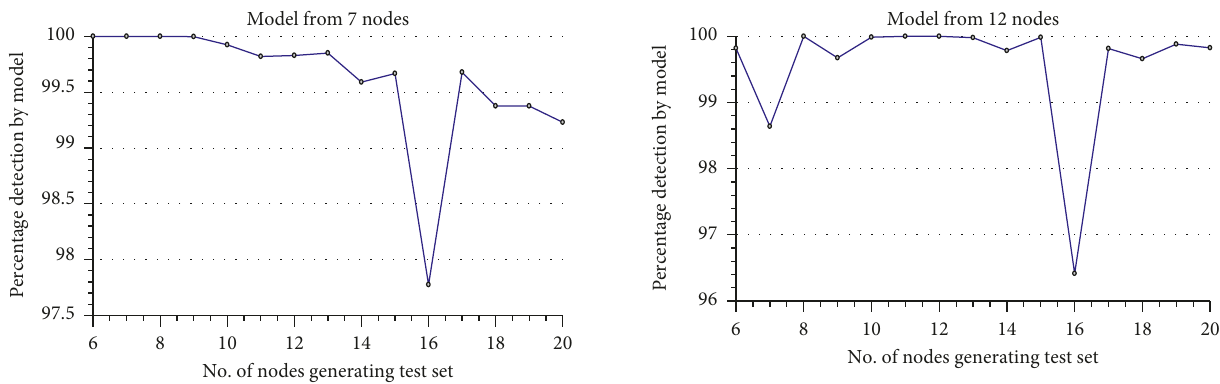
Figure 9: Simulation results for 7 nodes.